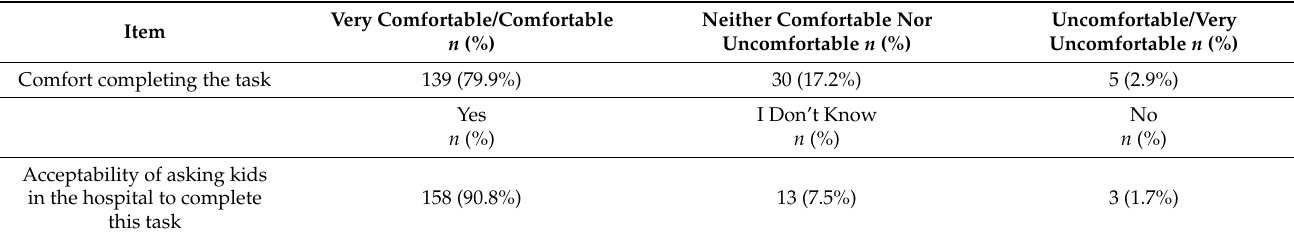
Table 2. Participant Comfort and Acceptability with the Death IAT ( n =